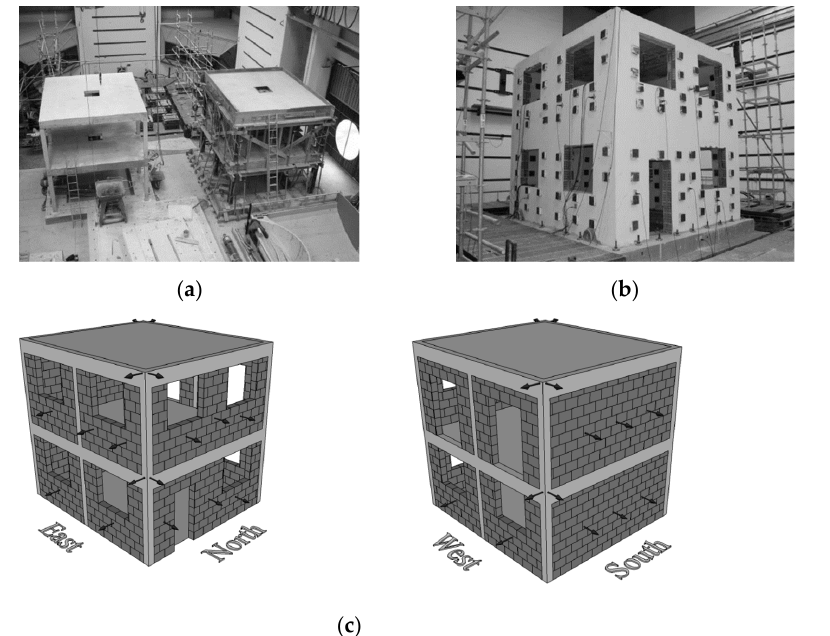
Figure 9. Model 1: ( a ) construction of the RC structure; ( b ) model on the shake table; ( c ) accelerom- eters setup.